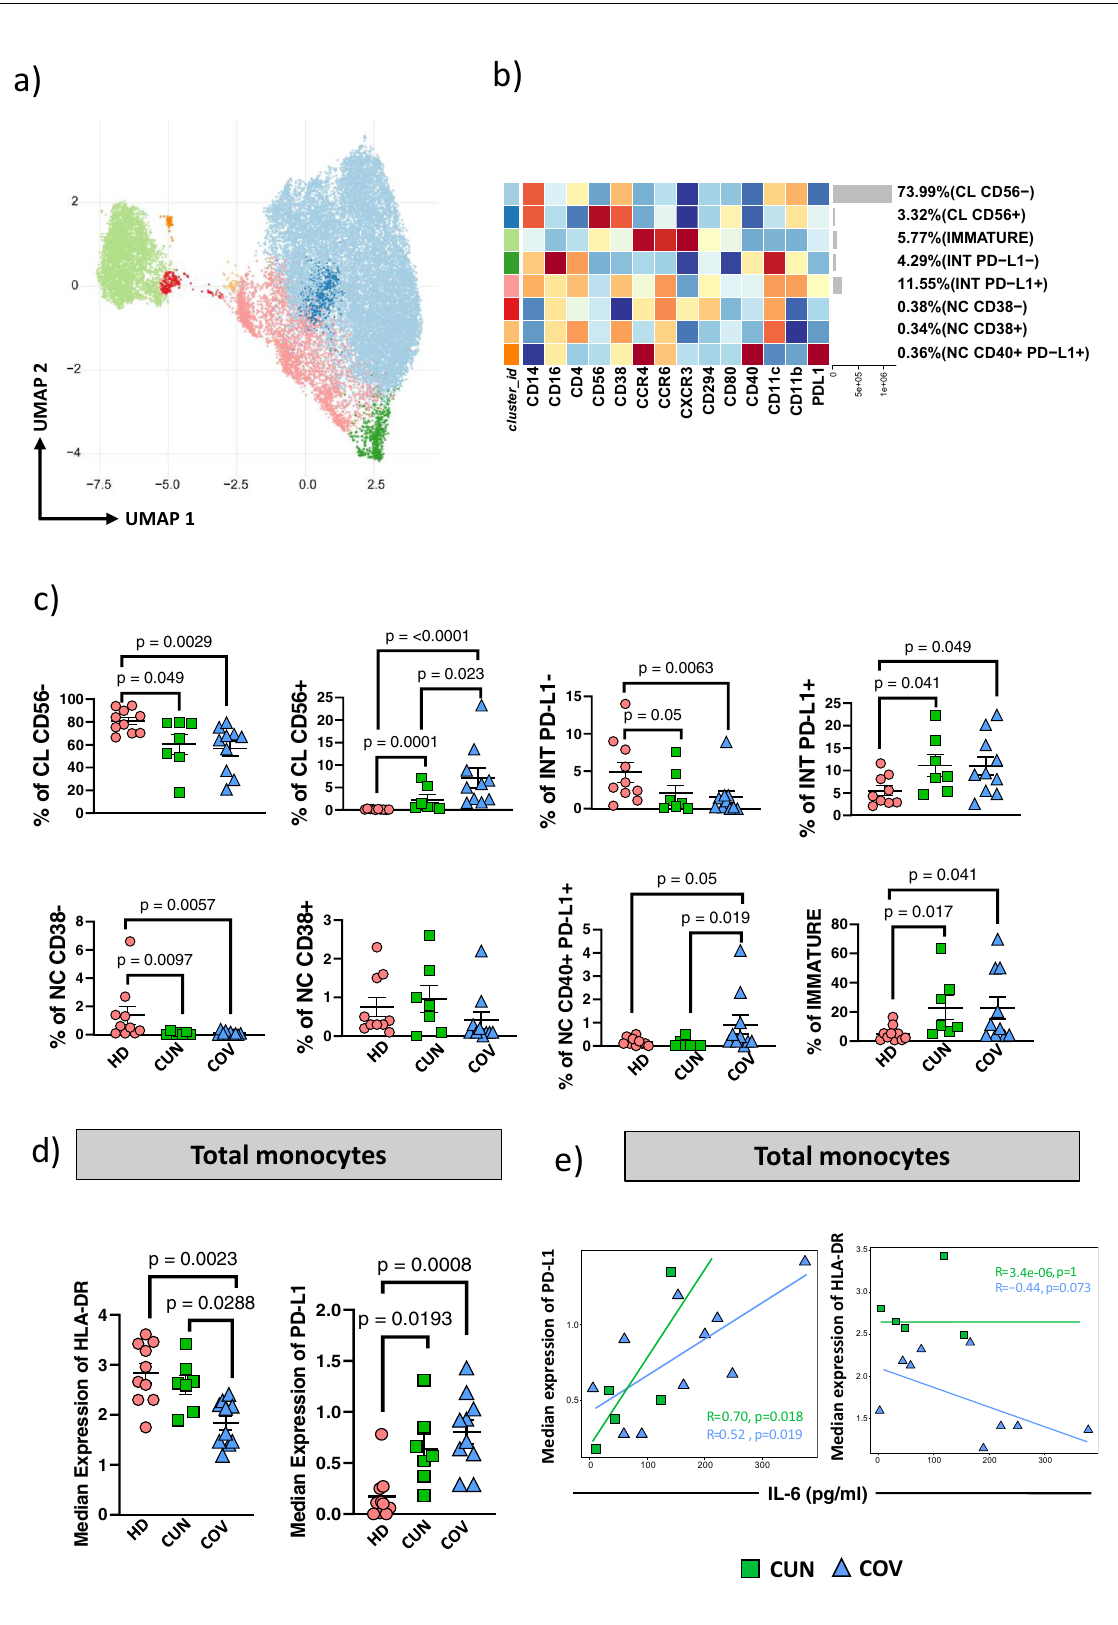
and on electronically gated population of T N , T CM , T EM , T EMRA CD4 + or CD8 + T cells. Supplementary Table 2 reports the complete list of mAbs used.